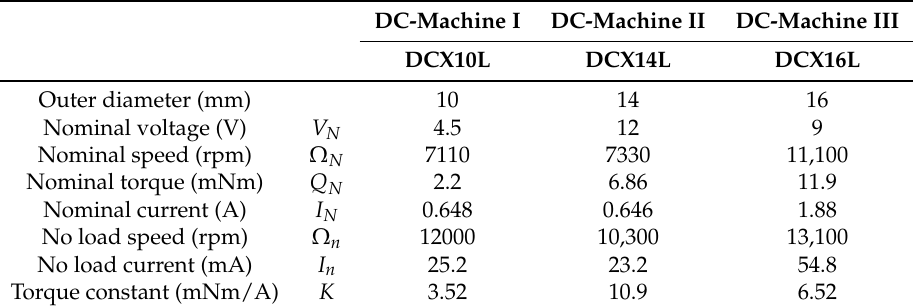
Table 1. Manufacturer-provided data of the DC machines studied in this paper. DC-Machine I DC-Machine II DC-Machine